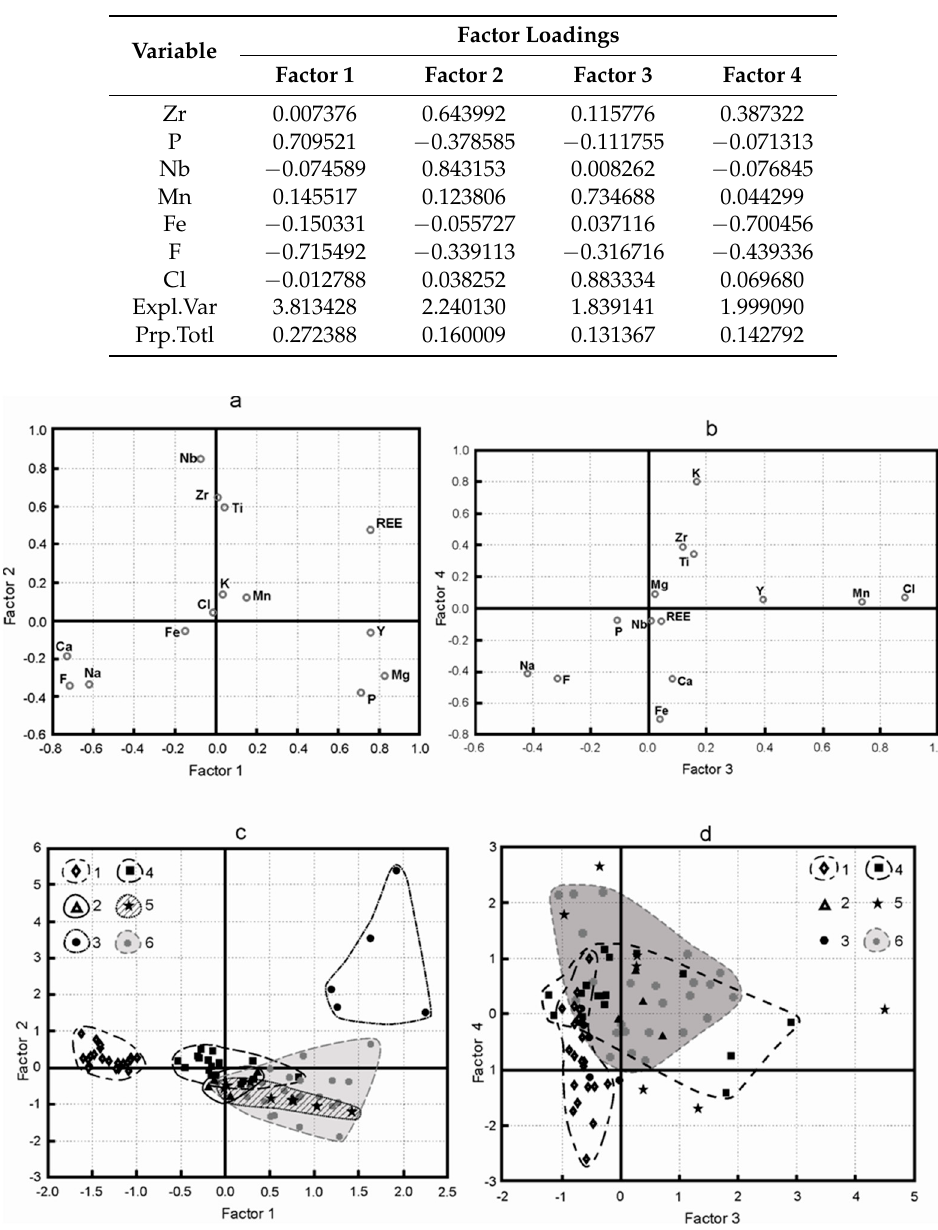
Figure 3. Loadings: Factor 1—Factor 2 ( a ) and Factor 3—Factor 4 ( b ). Scores: Factor 1—Factor 2 ( c ) and Factor 3—Factor 4 ( d ) with marked material types: 1—hainite-(Y), 2—“eye-like”, 3—“homogenous”, 4—“layered”, 5—“loose”, 6—“porous”.